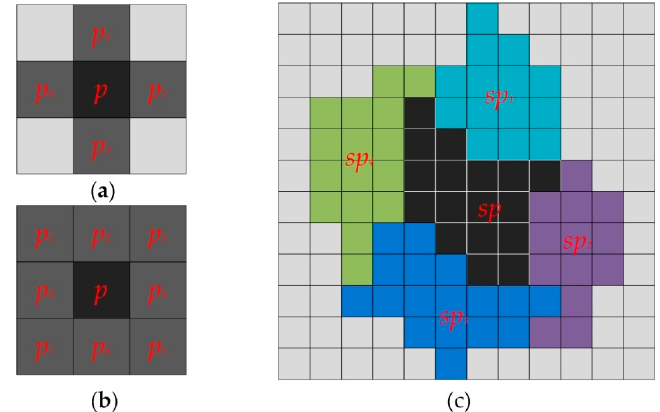
Figure 2. Definition of the neighborhood systems with the pixel and the superpixel: ( a ) pixel-based four-neighborhood system of center pixel p ; ( b ) pixel-based eight-neighborhood system of center pixel p and ( c ) superpixel-based neighborhood system of center superpixel s p .